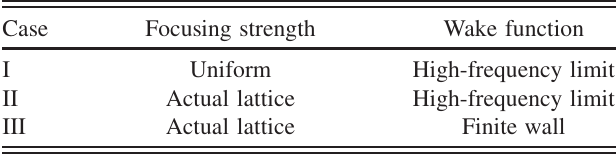
TABLE III. Conditions for wake function and jitter